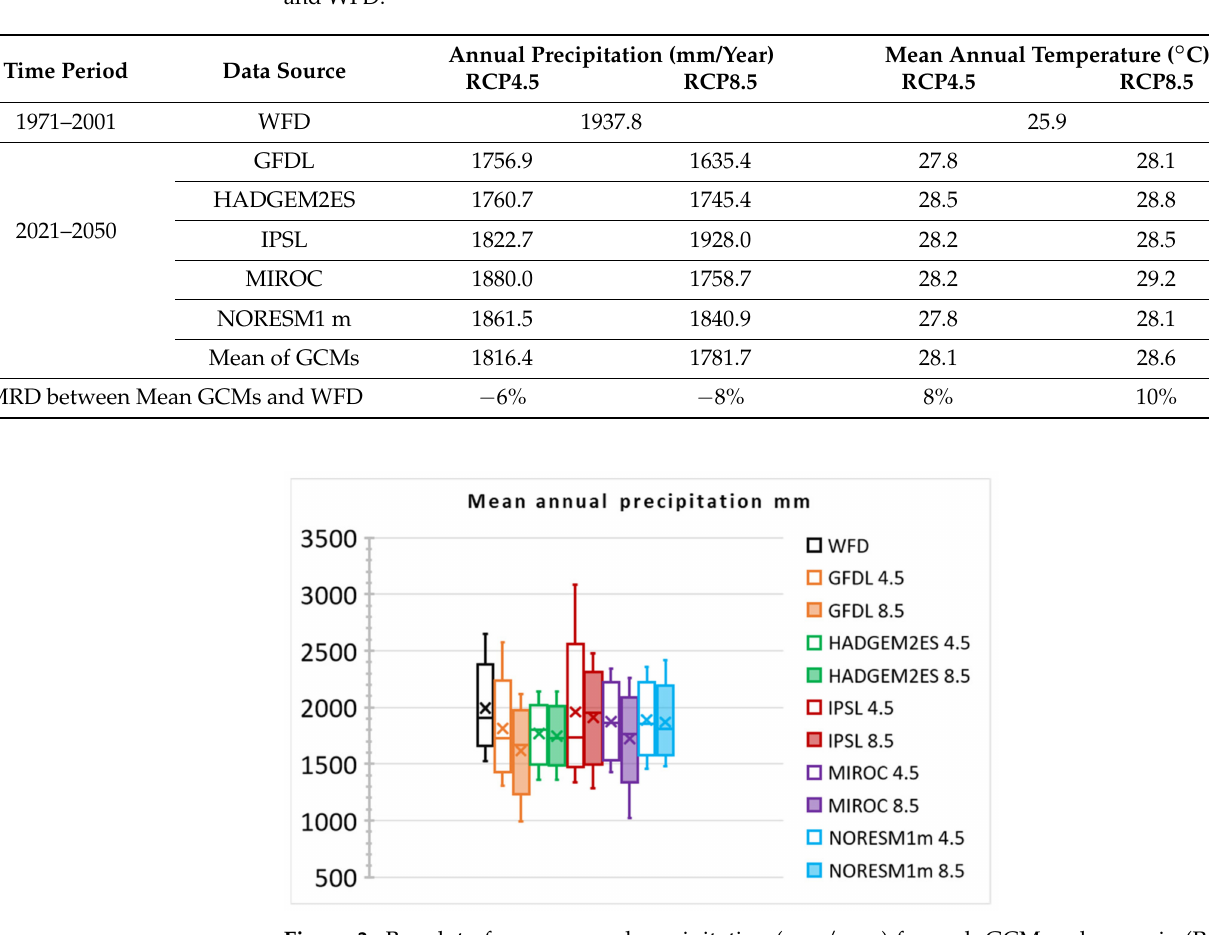
Table 3. Mean annual precipitation and temperature in the reference period (WFD) and future period (each GCM and mGCMs), and the mean relative difference (MRD) between the GCMs’ mean and WFD.